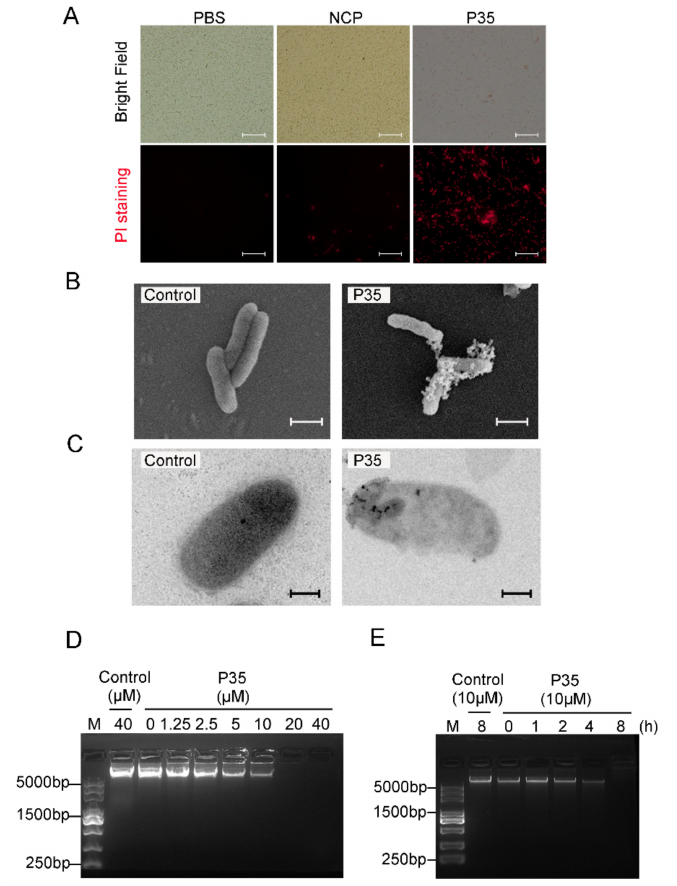
Figure 5. The damaging effect of P35 on bacterial structure and DNA. ( A – C ) Vibrio harveyi was incubated with P35, the negative control peptide (NCP), or PBS for 2 h and then subjected to PI staining ( A ), scanning electron microscopy ( B ), and transmission electron microscopy ( C ). Scale